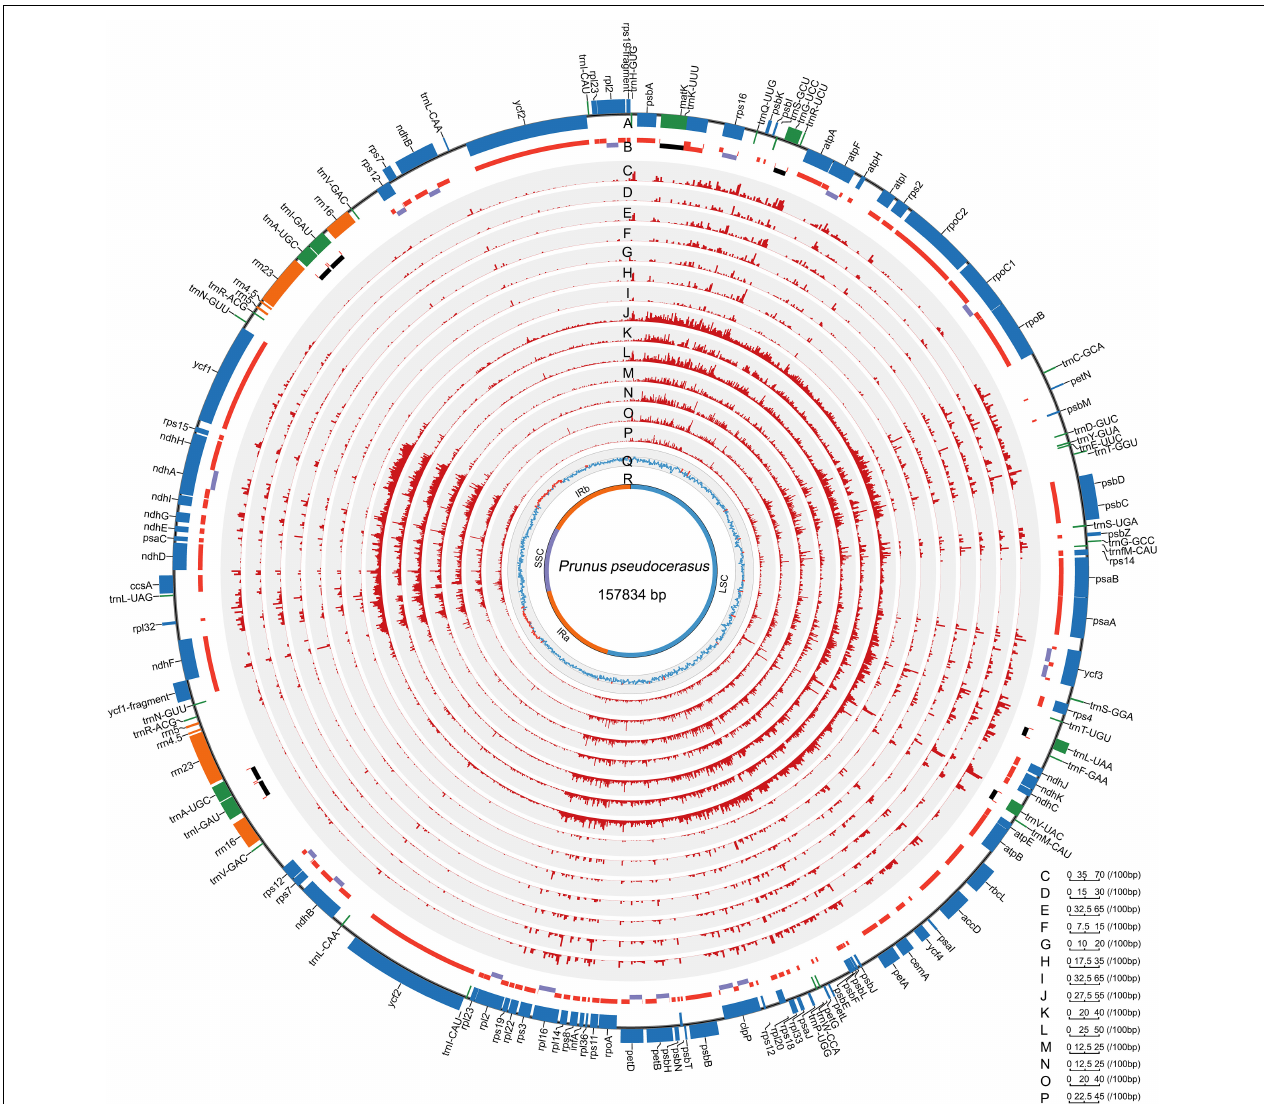
FIGURE 1 | Landscape of genomic variations across the 121 Rosaceae plastomes. A. Gene distribution (blue, protein-coding genes; green, tRNAs; orange, rRNAs). B. Exons and introns (red, exons in protein-coding genes; black, exons in tRNAs; purple, introns). C-I/J-P. Density of insertion-deletion (InDel)/single nucleotide polymorphism (SNP) in plastomes of the Rosaceae family, Rosoideae and Amygdaloideae subfamilies, and Spiraeeae, Exochordeae, Maleae, and Amygdaleae tribes (100-bp window). Q/R. GC contents/distributions of large single-copy (LSC), short single-copy (SSC) and two inverted repeats (IRs) (100-bp window; light blue, GC content over 50%; orange, GC content below 50%). Prunus pseudocerasus ( Cerasus pseudocerasus ) (NC030599.1) was used as reference